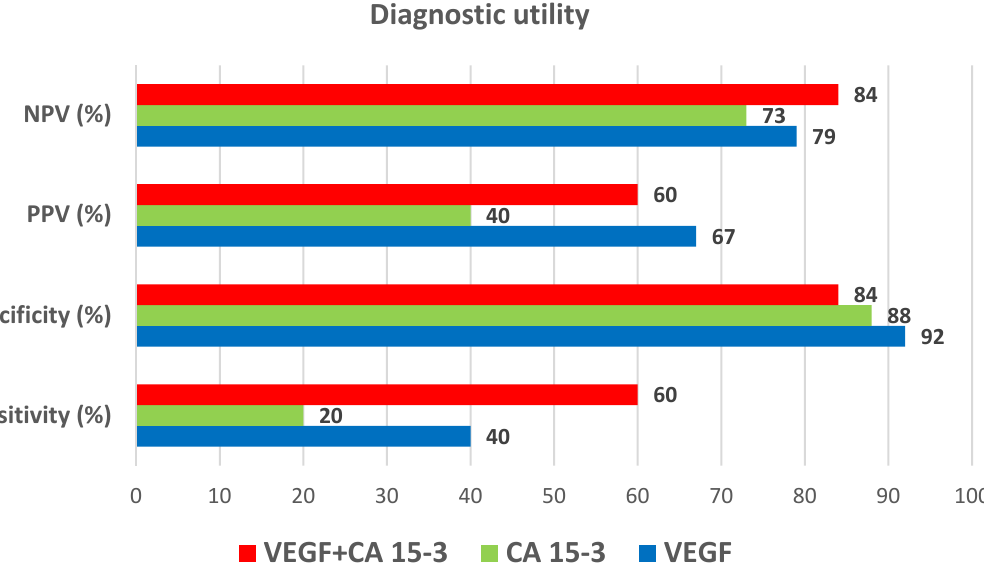
Figure 4. Diagnostic utility of VEGF and CA 15-3 in detection of breast cancer recurrence. The diagnostic power of detecting BC recurrence was highest for VEGF (AUC = 0.6454), which was higher than for CA 15-3 (0.5939), and increased to 0.7074 in the combined analysis of both parameters (Figure 5).